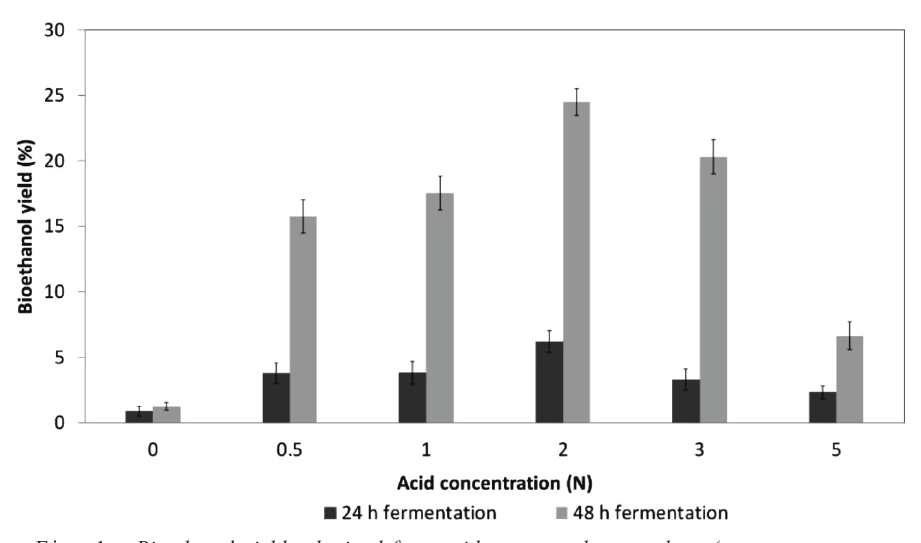
Fig. 1 – Bioethanol yields obtained from acid pre-treated macroalgae (pre-treatment tem- perature: 100 °C, pre-treatment time: 60 min)